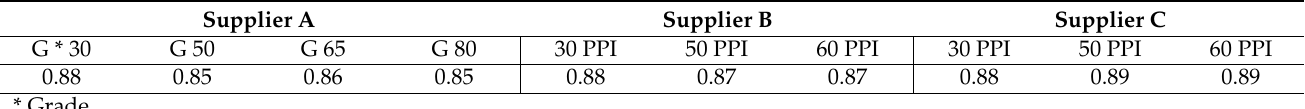
Table 3. The average porosity of CFF from suppliers A, B, and